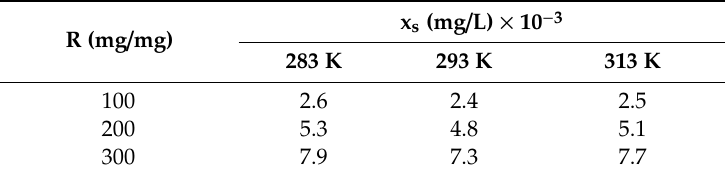
Table 2. Bio-adsorbent concentrations in batch